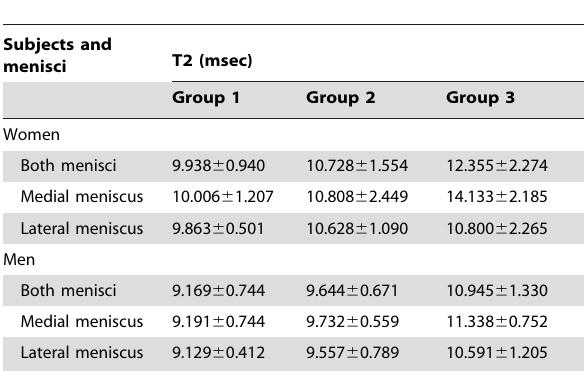
Table 2. Meniscal T2 measurements in different groups.